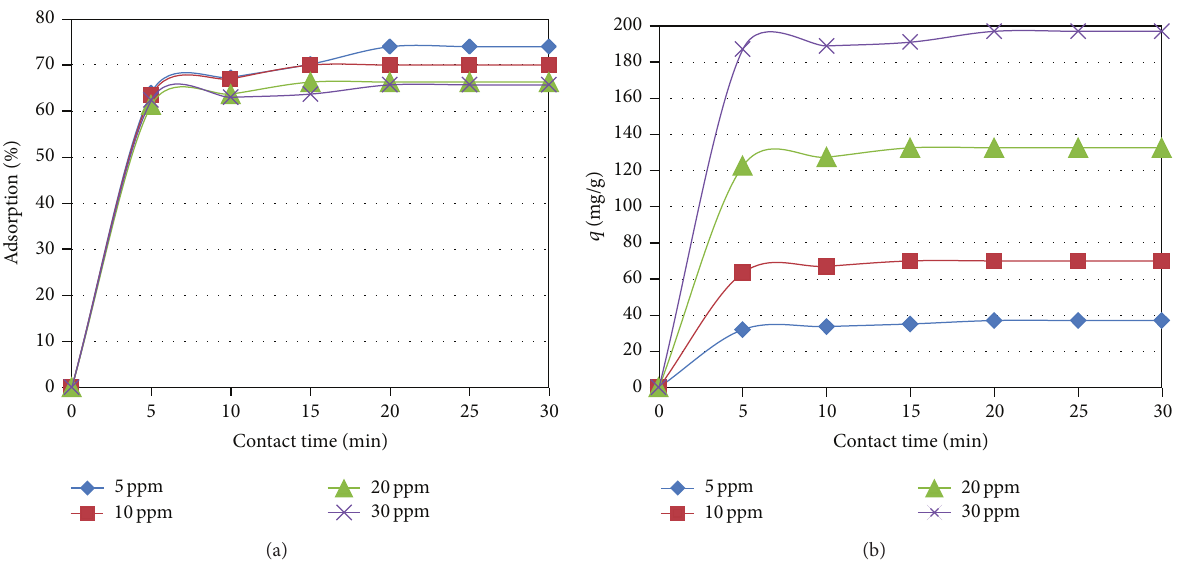
Figure 7: (a) Effect of contact time on basic orange dye adsorbed % (pH = 8.5, CNTs dosage = 100mg/L). (b) Effect of contact time on basic orange dye adsorption capacity (pH = 8.5, CNTs dosage = 100 mg/L).